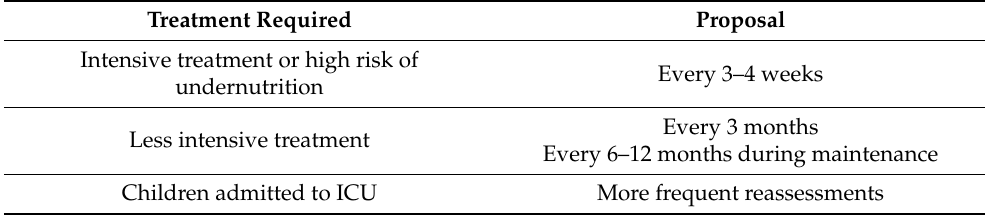
Table 2. Proposed timing of nutritional assessment during pediatric cancer